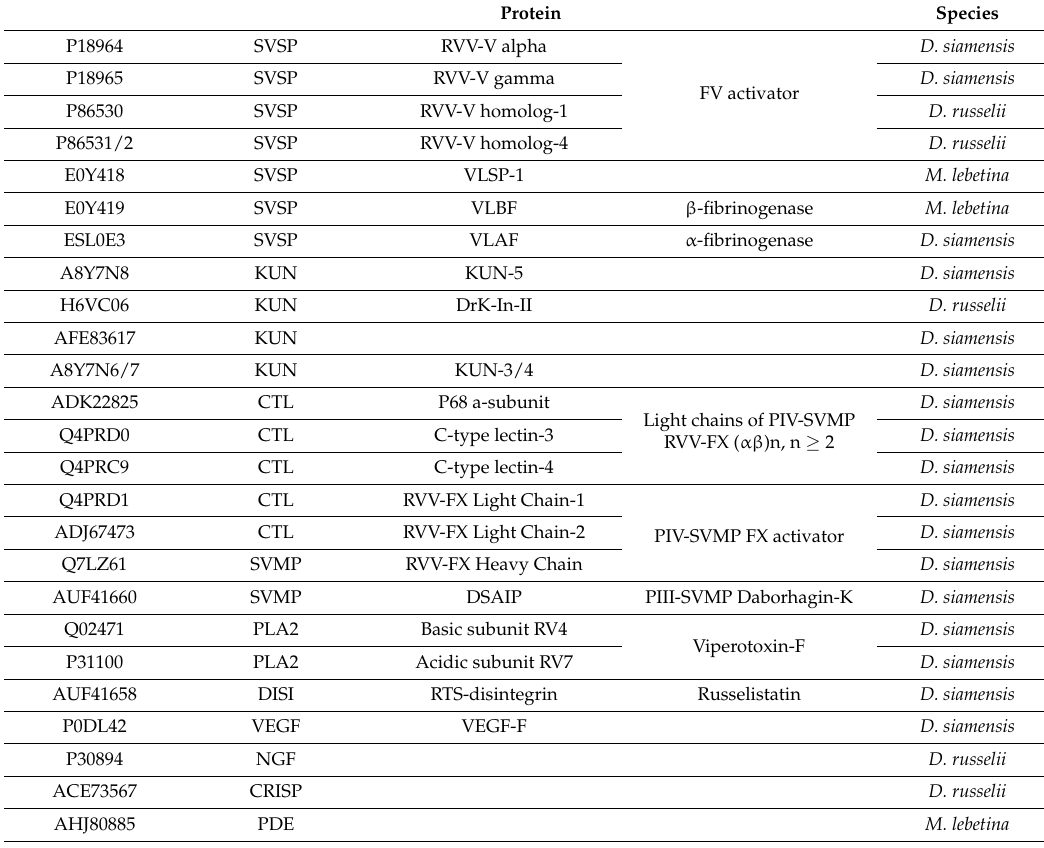
Table 1. Summary of the proteins that make up the venom proteome of Siamese Russell’s viper from Taiwan. For details of venomics assignments, consult Supplementary Materials Table